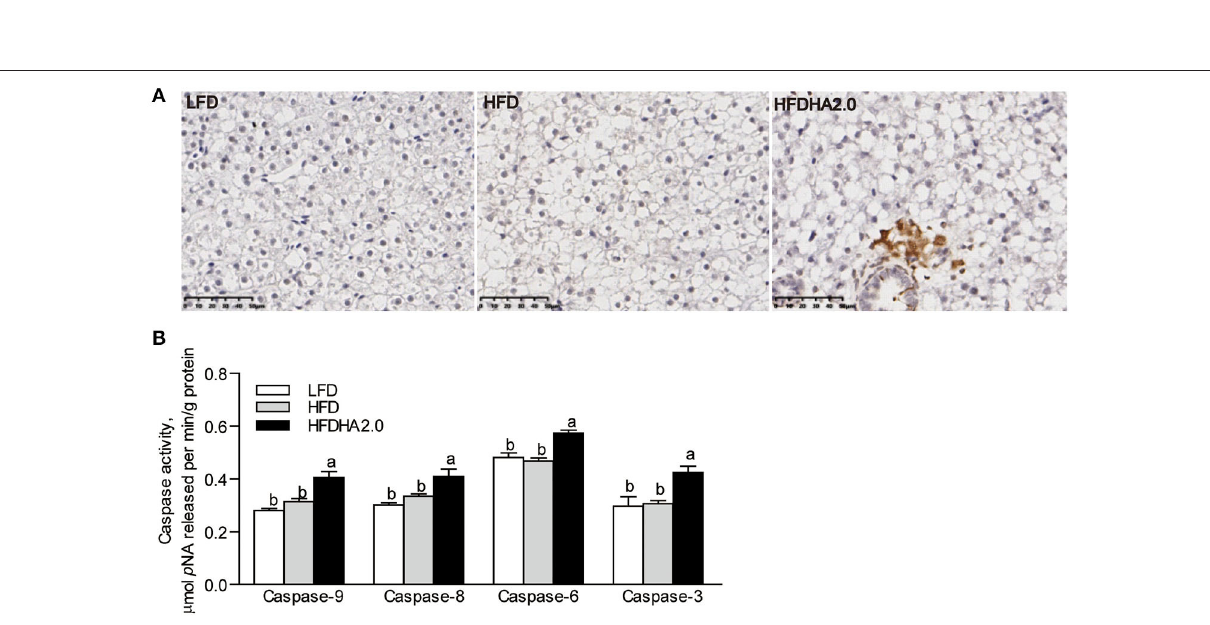
Frontiers in Nutrition |